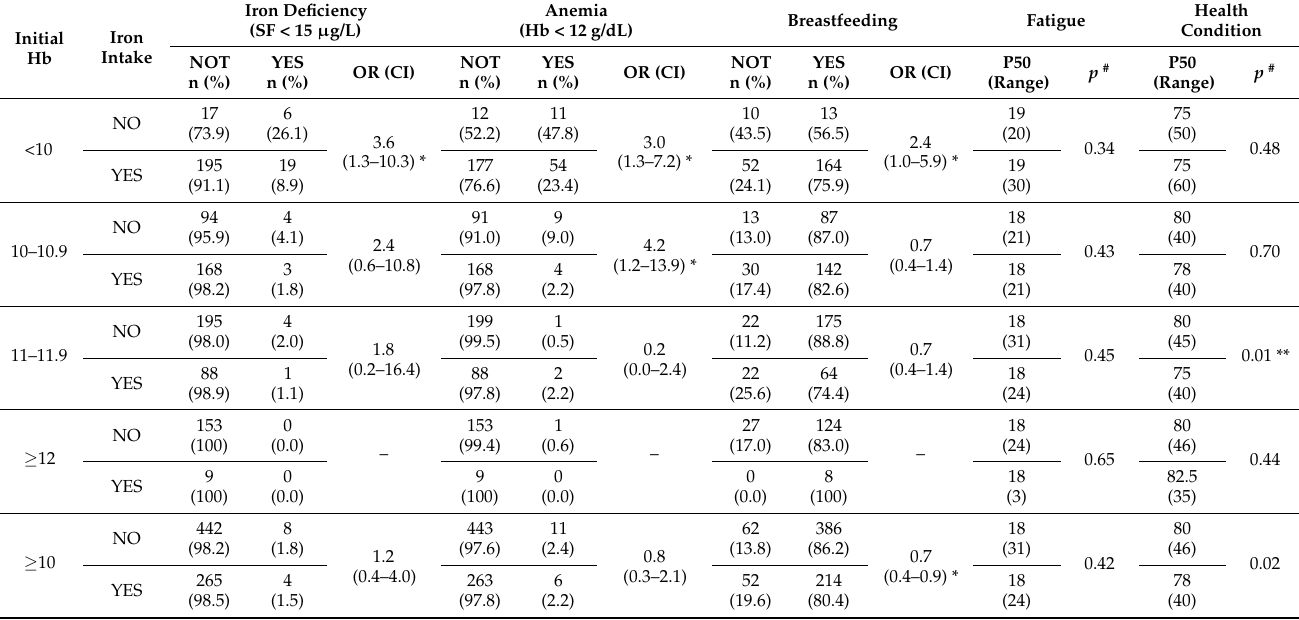
Initial Hb measured in the first 24 h postpartum. Hemoglobin values are broken down into eight sections: four correspond to the diagnosis of anemia (Hb <10 g/dL) and four to those without anemia (Hb ≥ 10 g/dL). P50 = 50th percentile (median) and range = interquartile